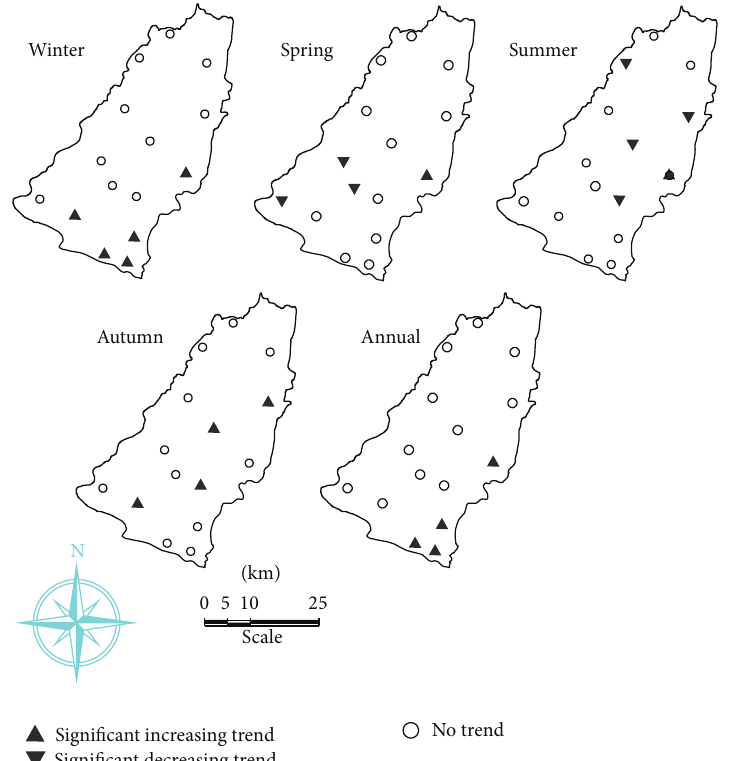
Figure 5: Location of sites with increasing, decreasing, and no trends at 5% significance level for the seasonal and annual precipitation time